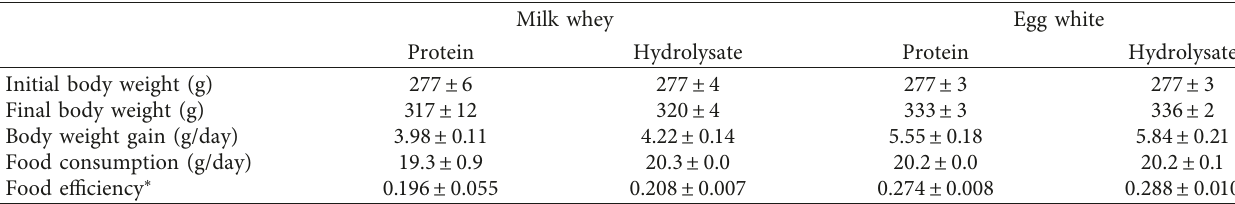
Table 3: Faecal and urine nitrogen content in rats fed a diet containing protein or hydrolysate of milk whey or egg white. Milk whey Egg white Protein Faecal weight (dry ·